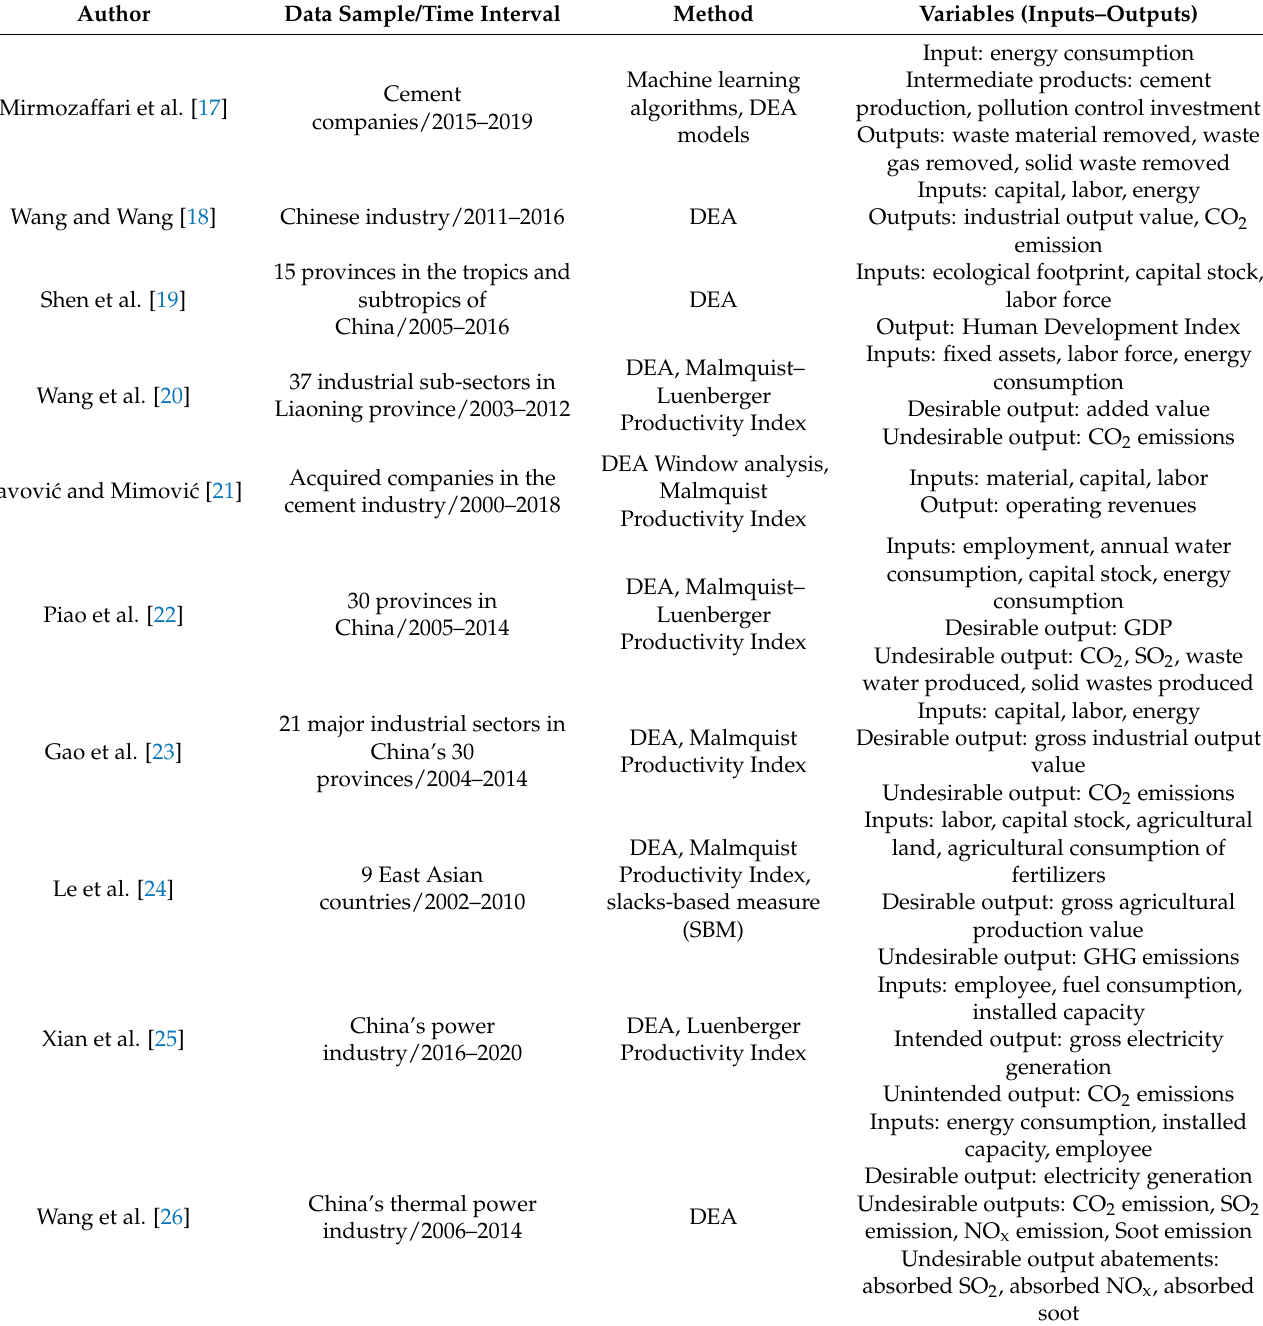
Table 1. Methodology and input/output factors used in the previous